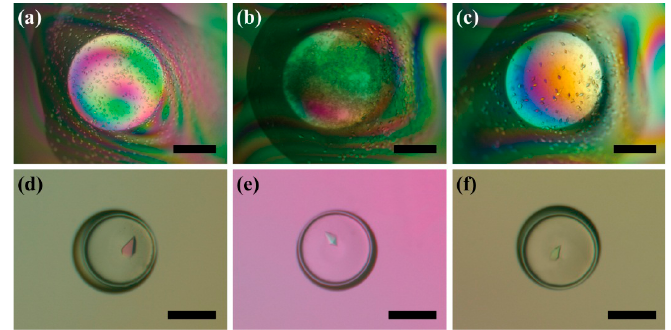
Figure 11. Polarized light photographs showing the screening results for thaumatin under three successful screening conditions: C5 ( a , d ); D2 ( b , e ); and F2 ( c , f ). The upper photographs were obtained by the conventional microbatch method and the lower ones by the double emulsion-based microbatch method. Scale bars: (a–c) 500 μm, (d–f) 300 μm. method. Scale bars: ( a – c ) 500 µ m, ( d – f ) 300 µ